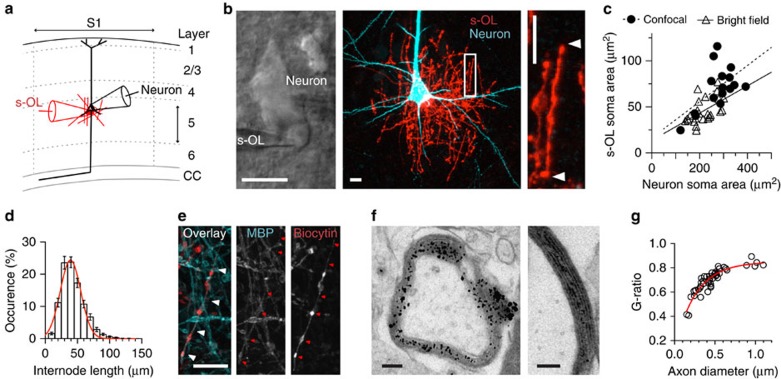
Experimental targeting of s-OLs reveals compact myelin and wrapping of surrounding axons.(a) Illustration of the experimental approach. s-OL (red) and layer 5 neuron (black) targeted with patch-clamp pipettes in mouse primary somatosensory neocortex. (b) Left: Bright-field image of a neuron–s-OL pair. Patch pipettes are visible. Middle, right: Confocal maximum z-projected image of a neuron–s-OL pair after intracellular loading with Alexa 488 (neuron) and Alexa 594 (s-OL) dyes. The white box is displayed at higher magnification on the right. White arrows indicate one internode. All scale bars, 10 μm. See Supplementary Movie 2. (c) Correlation of soma size between neurons and s-OLs as estimated from two separate data sets. Closed circles display data from maximum z-projected live-confocal scans and open triangles are measurements from bright-field images. Both data sets were fit by linear regressions (confocal scans: n=16, correlation coefficient r2=0.33, P=0.02; bright field: n=24, r2=0.29, P=0.007). (d) Distribution histogram of s-OL internode length measured from confocal live image z-stacks (n=32 cells). The data were fit by a Gaussian function (red line, y=24.36*e(−0.5*((x-39.30)/15.93)2)). Data presented are mean±s.e.m. (e) A s-OL was filled with biocytin and Alexa 594 during recordings and subsequently post hoc labelled for myelin basic protein (MBP). Internodal structures are positively co-labelled by MBP and biocytin (red and white arrowheads). Scale bar, 10 μm. (f) Left: electron microscopy image of an identified horseradish peroxidase (HRP)-filled transversal cut s-OL process shows multiple layers of myelin wrapped around an axon. Gold particles are visible as black dots in the outer tongue and all myelin layers, suggesting a direct cytoplasmic connection with the cell body. Right: a putatively different axon at higher magnification shows about seven gold-labelled compact myelin wraps. See also Supplementary Fig. 2. Scale bars, 100 nm. (g) The g-ratio measured from single identified s-OL axons (n=45) plotted as function of the axon diameter. s-OLs myelinate axons of variable diameter. The data were fitted with an exponential equation (y=−0.723 × e (−0.0038 × x)+0.85).